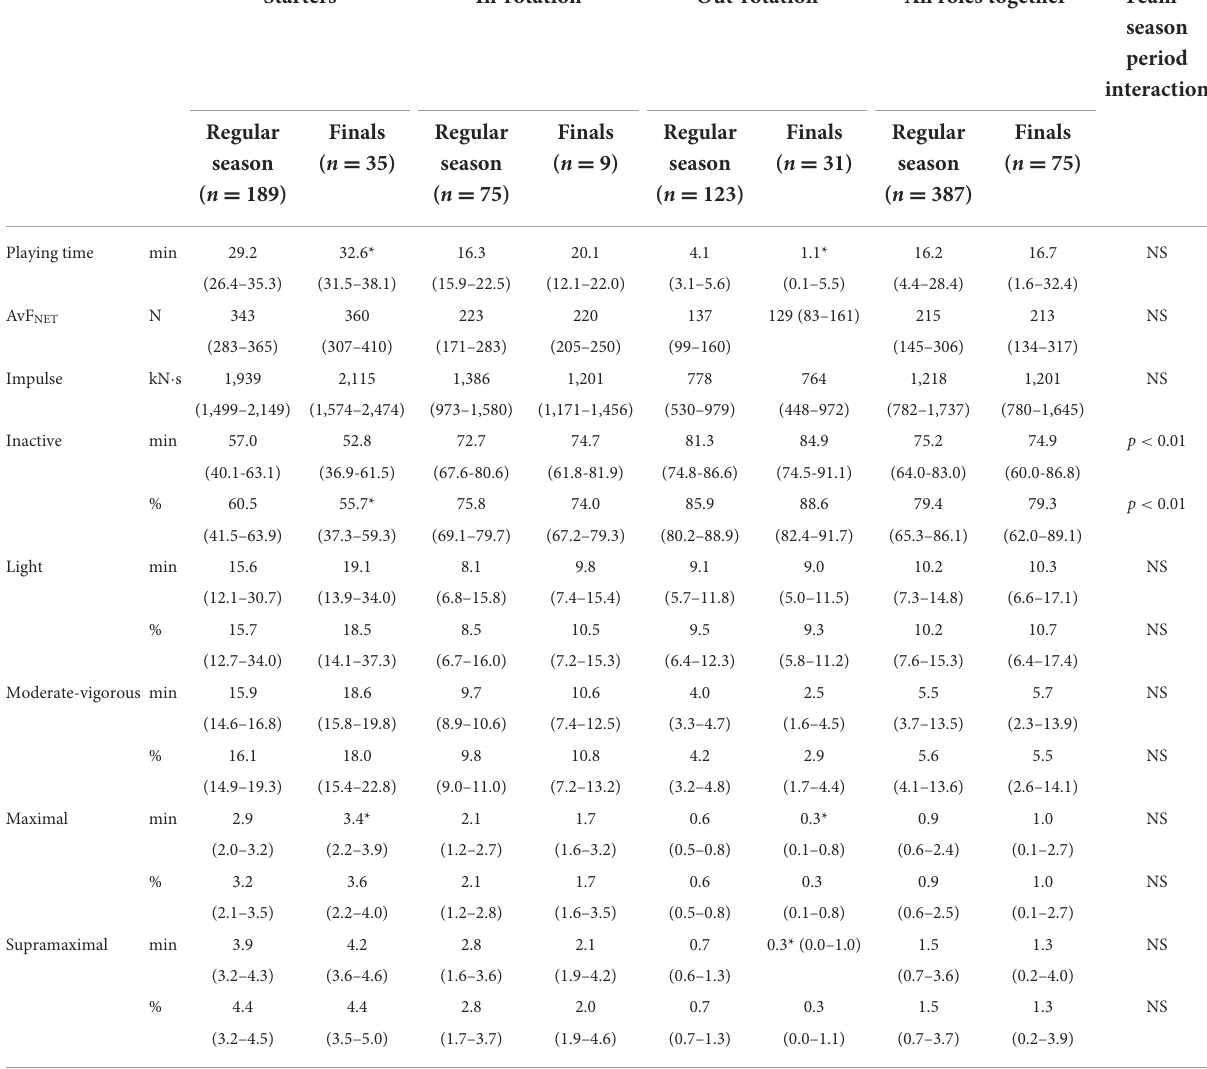
TABLE 2 On-court activity during matches in the regular season and